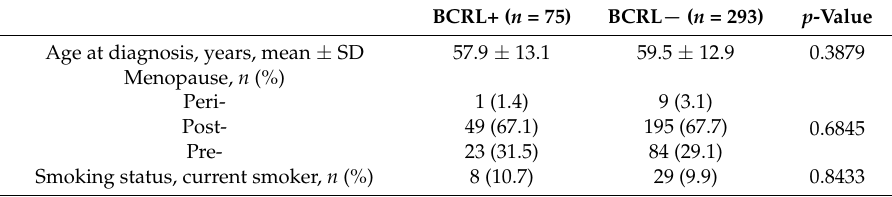
Table 1. Demographic data and general characteristics of the patients included in the study. BCRL, breast cancer related lymphedema; SD, standard deviation; BMI, body mass